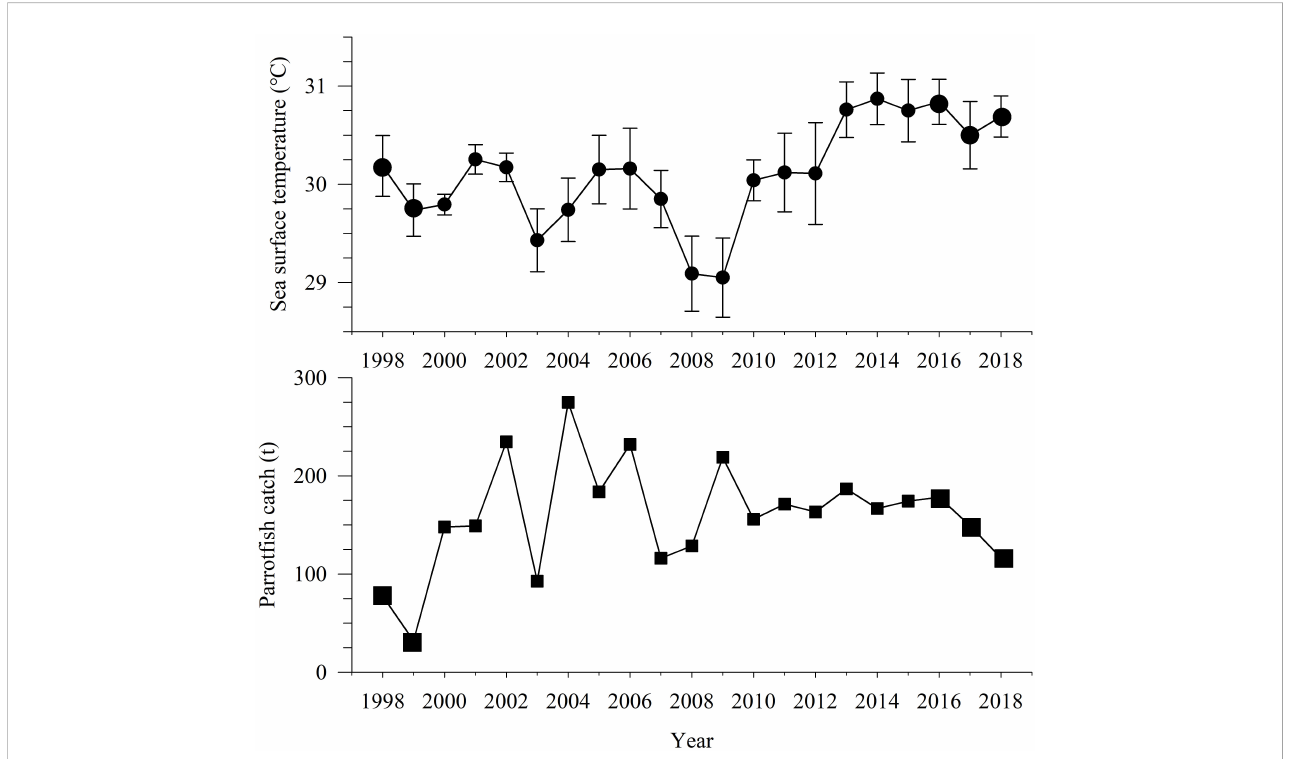
FIGURE 6 Variation of mean sea surface temperature in May 1998 – 2018 in the Yongshu Reef and catches of parrot fi sh from China1998 – 2018 in the South China Sea. The error bar represents the corresponding standard deviation.